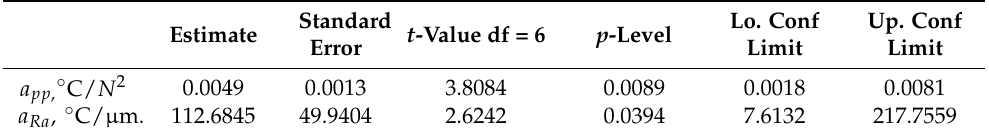
Table 8. Significant regression coefficients (1) for lubricated (MQL) burnishing. Standard t -Value df = 2 p -Level Estimate Error a pp , ◦ C/ N 2 0.0033 0.0004 8.5939